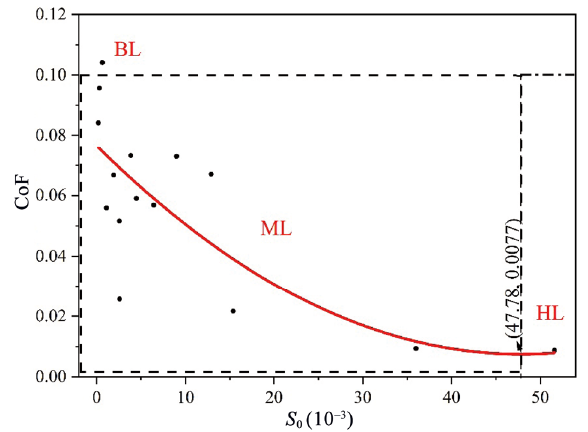
Fig. 9 Stribeck-like curve of Cu–15Ni–8Sn–0.8Nb alloy/300M steel tribo-pair under grease-lubricated